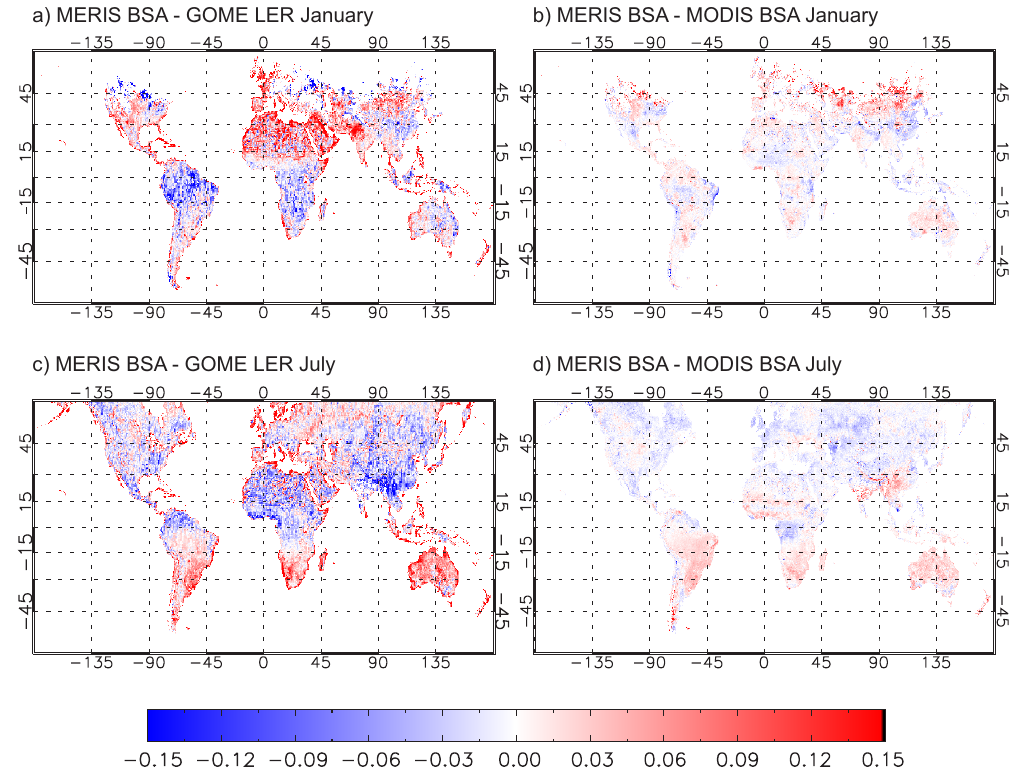
Fig. 4. Difference maps of MERIS BSA–GOME LER (754nm and 758nm) and MERIS BSA–MODIS BSA (865nm and 858nm) for January and July,